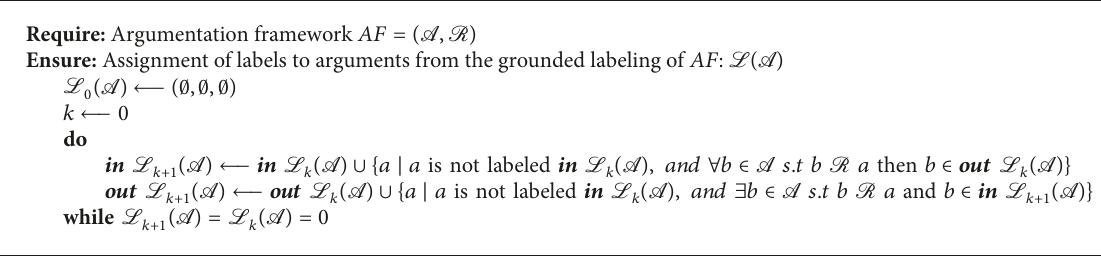
Algorithm 3: Solve argumentation frameworks (with grounded semantics).